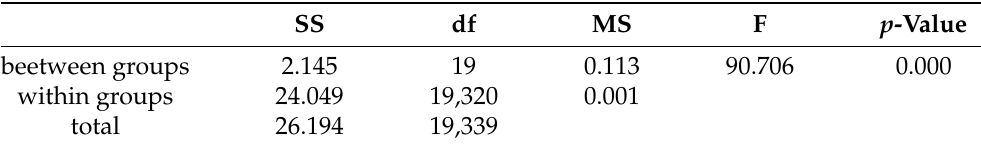
Table 8. ANOVA analysis of the channel-wise attention weights in the HR estimation. SS denotes the sum of squares, df denotes the degree of freedom, MS denotes the mean square, and F denotes the F-statistic. SS df